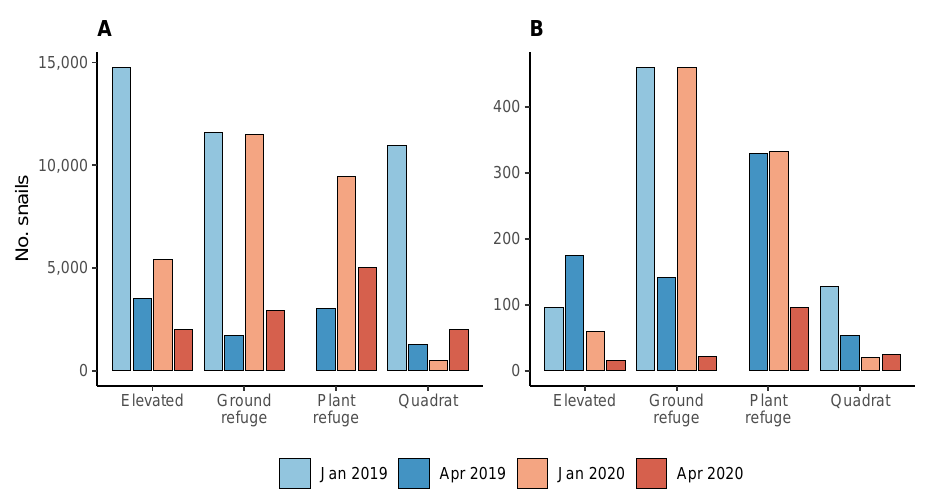
Figure 2. Total numbers of snails collected by habitat and sampling date for: ( A ) C. acuta at 19 sites ; and ( B ) C. barbara at 11 sites. Plant refuges were not sampled in January